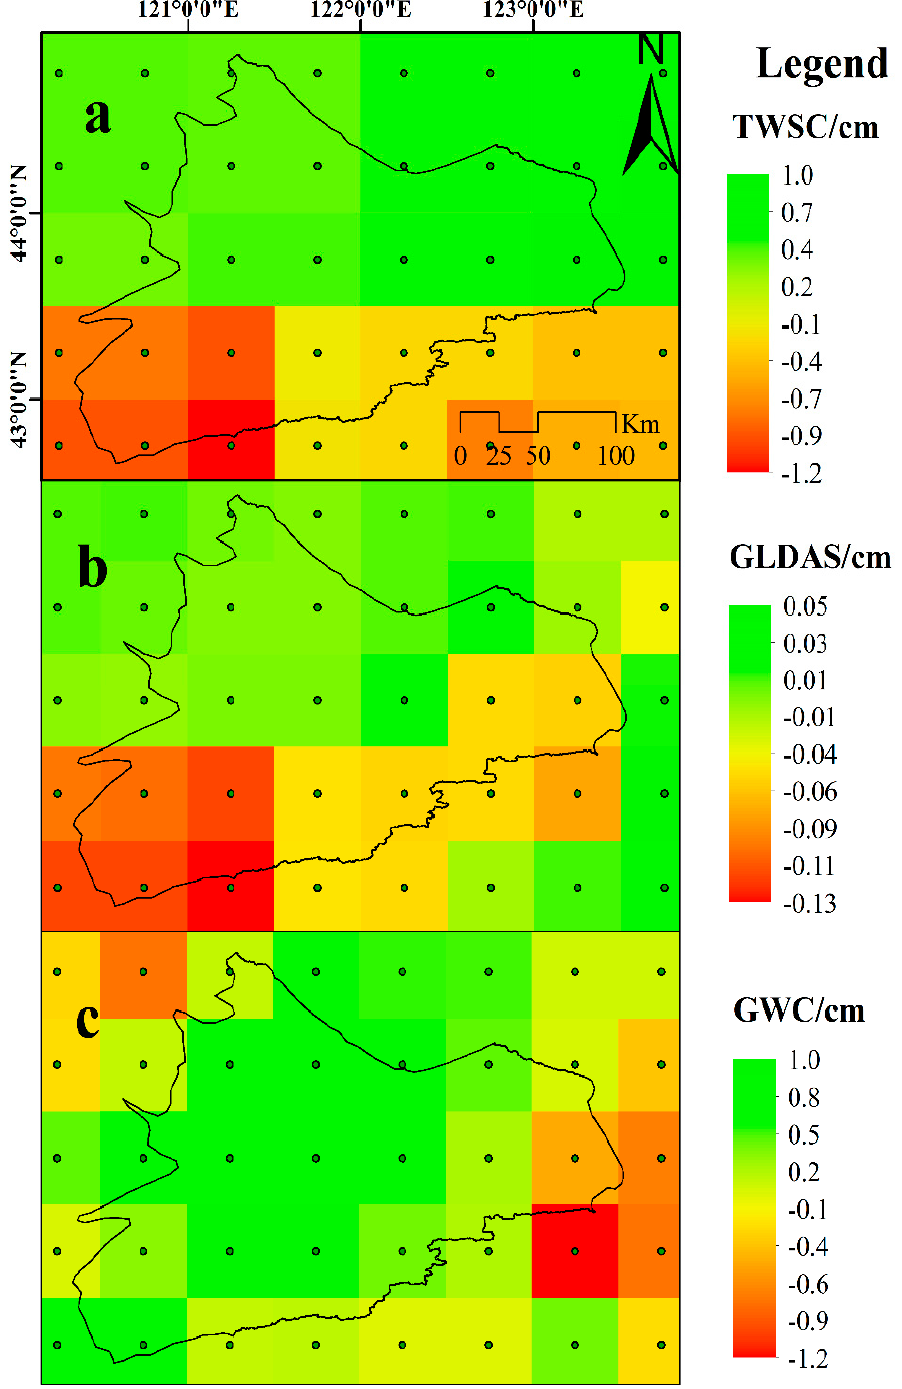
Figure 5. Spatial distribution of TWSC ( a ), GLDAS ( b ) and GWC ( c ) from 2002~2014 (Grid cell size: